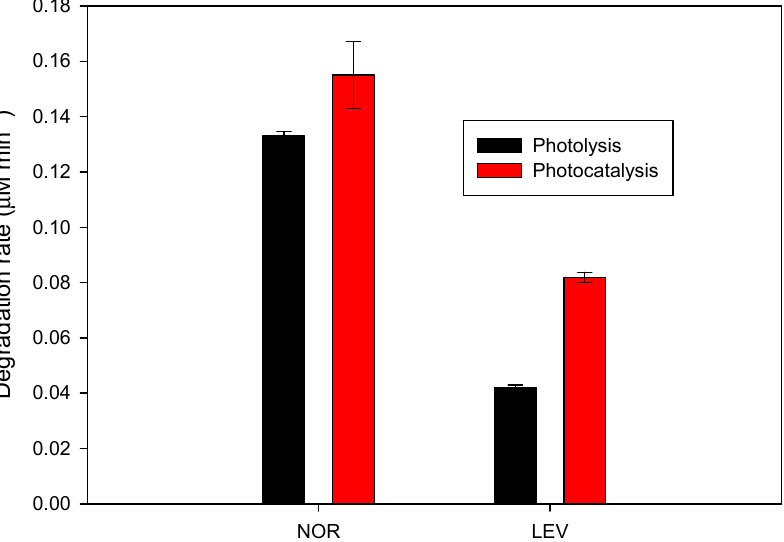
Figure 2. Degradation rates for the treatment of NOR and LEV by photolysis (UVA alone) and pho- tocatalysis (UVA/CdS). Experimental conditions: [NOR] = [LEV] = 13.8 µM, [CdS] = 0.5 g L − 1 , UVA intensity = 40 W m − 2 , and initial pH =